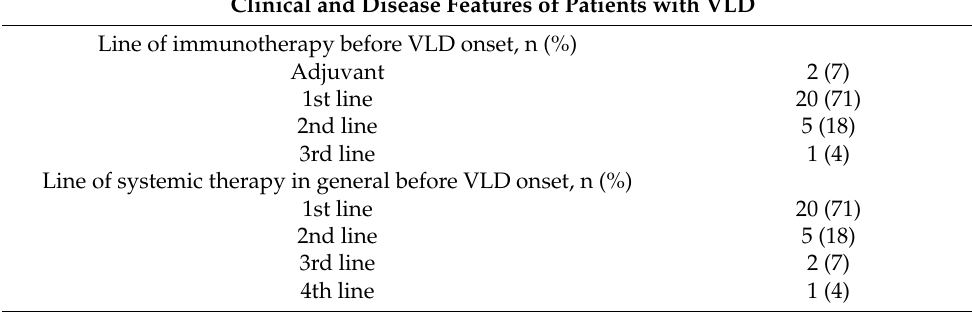
Table 1. Cont . Clinical and Disease Features of Patients with VLD Line of immunotherapy before VLD onset, n (%)